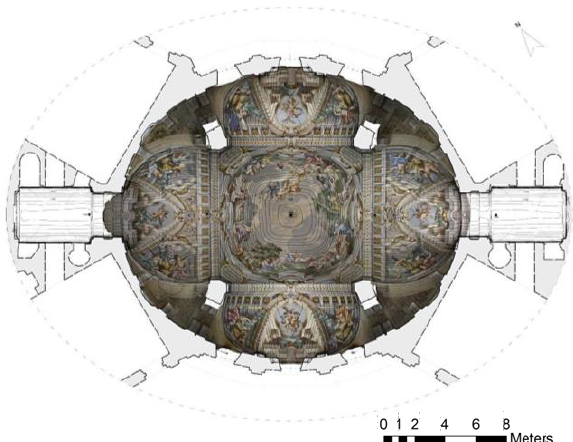
Figure 4. Orthophoto integrated in a 2D representation with contours